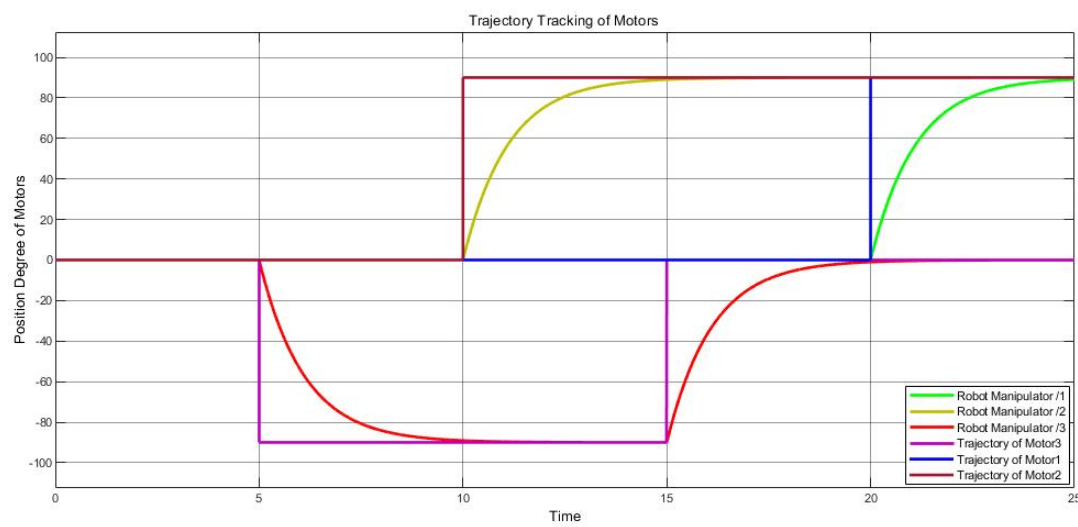
Figure 17. Trajectory of passive exercise